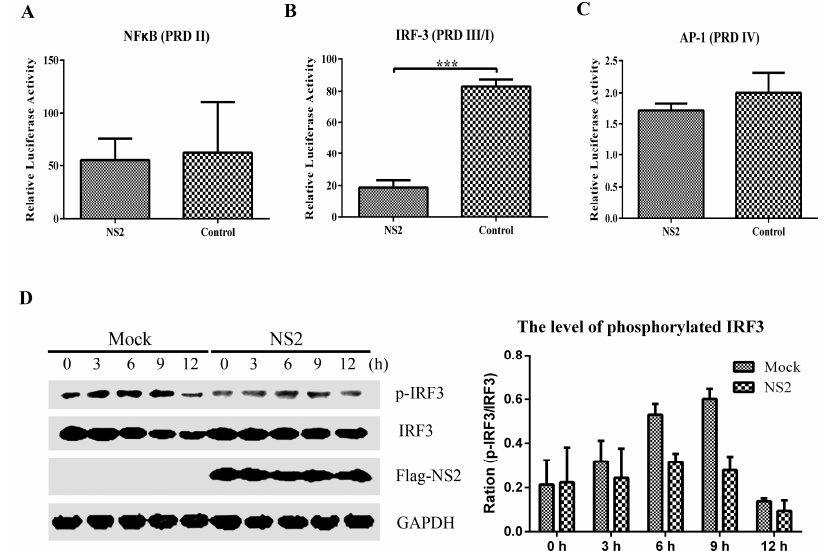
Figure 3. Inhibition of the activity of transcription factors on specific PRDs of the IFN ‐β promoter by NS2. F81 cells were co ‐ transfected with p3×Flag ‐ NS2, pRL ‐ TK and either p3×PRDII ‐ Luc ( A ), PRDIII/I ‐ Luc ( B ), or p6×PRDIV ‐ Luc ( C ). At 12 h post ‐ transfection, the cells were inoculated with SeV. Twelve hours after infection, the cells were harvested and the luciferase activities were measured. The values were normalized to the Renilla activity. The error bars represent standard deviations, and the asterisks indicate significant differences (*: p < 0.05; **: p < 0.01; ***: p < 0.001) between groups. ( D ) The phosphorylation levels of IRF3 in the cells stimulated with SeV after transfection with NS2. F81 cells were transfected with p3×Flag ‐ NS2. At 12 h post ‐ transfection, the cells were inoculated with SeV. The cell lysates at 0, 3, 6, 9 and 12 h after SeV infection were analyzed by immunoblotting using antibodies against IRF3 or phosphorylated IRF3 and the quantification of relative p ‐ IRF3 band intensities to IRF3 was showed with histogram.